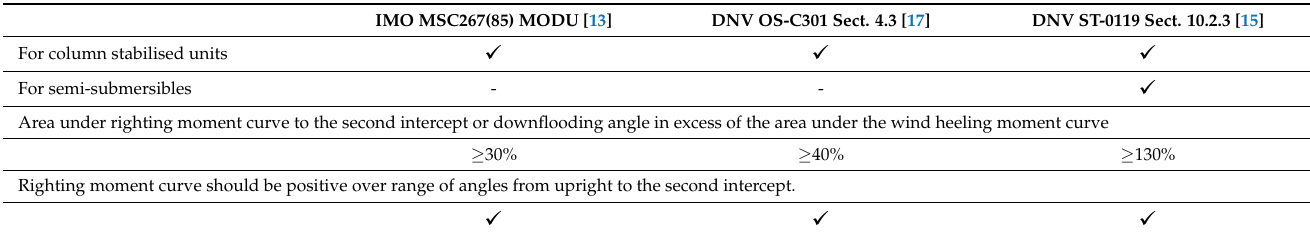
Table 2. Requirements set by standards.